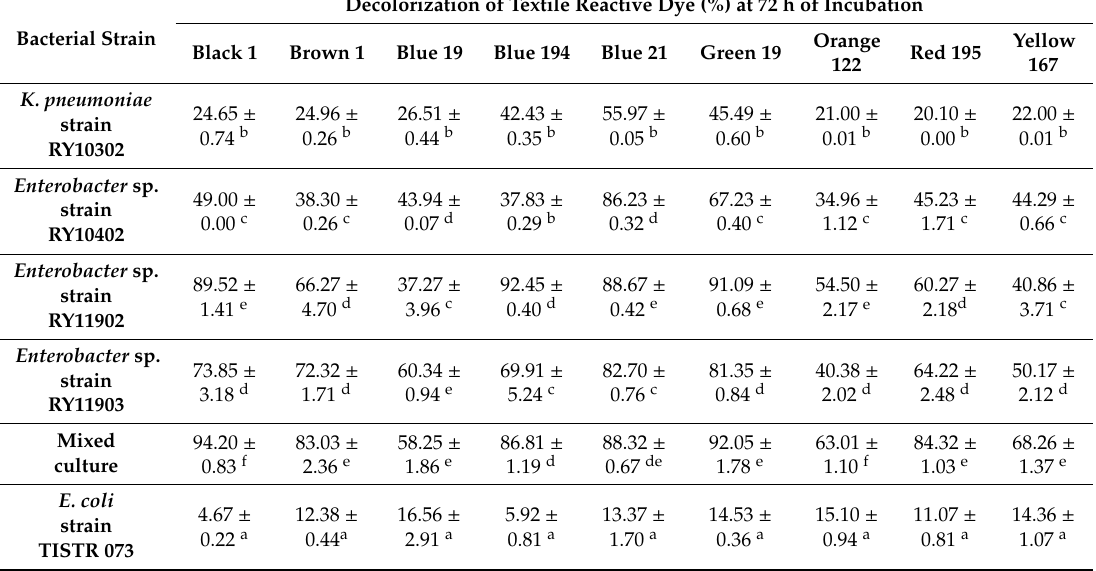
Table 5. Decolorization of textile reactive dyes by various dye-decolorizing bacteria under experimental conditions at 72 h of incubation.